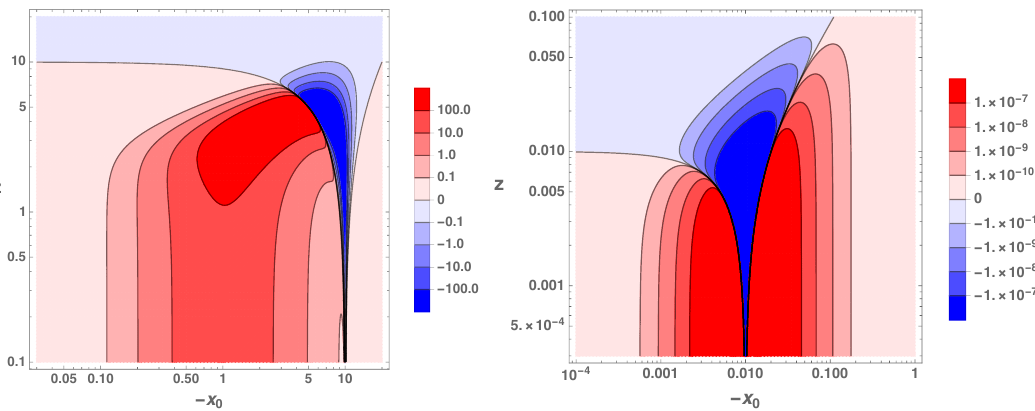
Figure 5 . The topological charge density (3.25) (multiplied by the volume factor 4 πx 4 ) of the instanton-anti-instanton (3.22) with ρ = 1 and d = 10 (0 . 01) for the left (right) figure. The contours are drawn for x 0 < 0 and x 1 = x 2 = x 3 = 0 and show an anti-instanton appearing at x 0 = − 10 ( − 0 . 01) whose size grows with increasing z and annihilates the instanton located at x 0 = 0 . Note the contours of the topological charge density are much smaller in the right